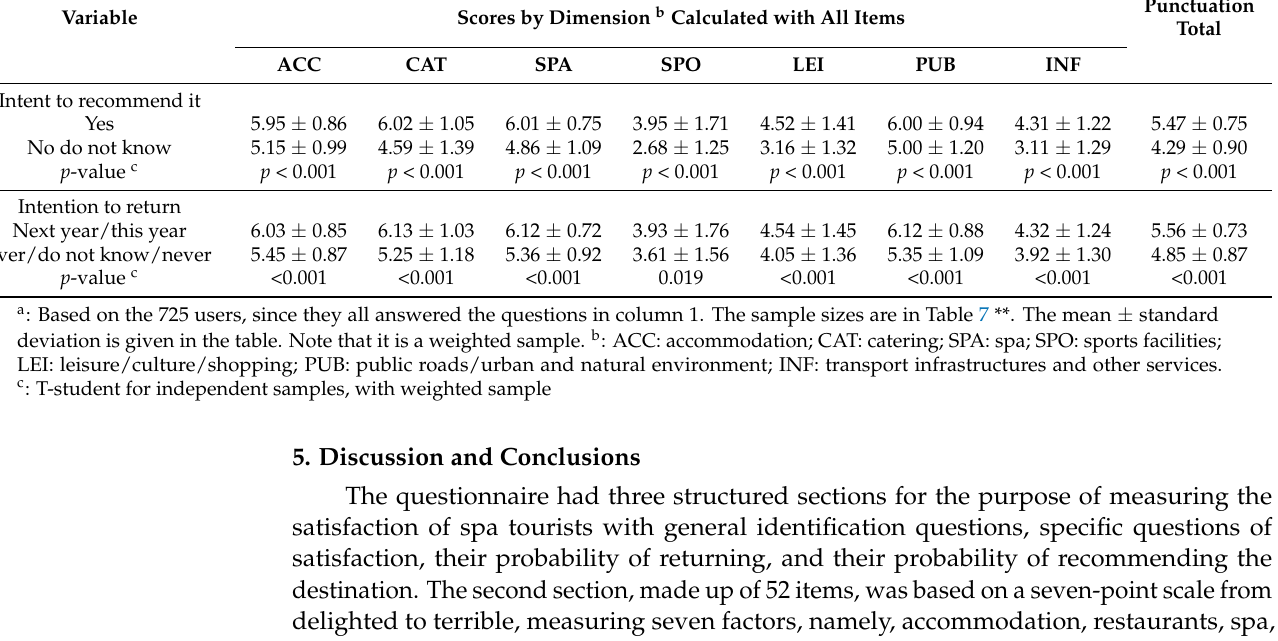
Punctuation Total